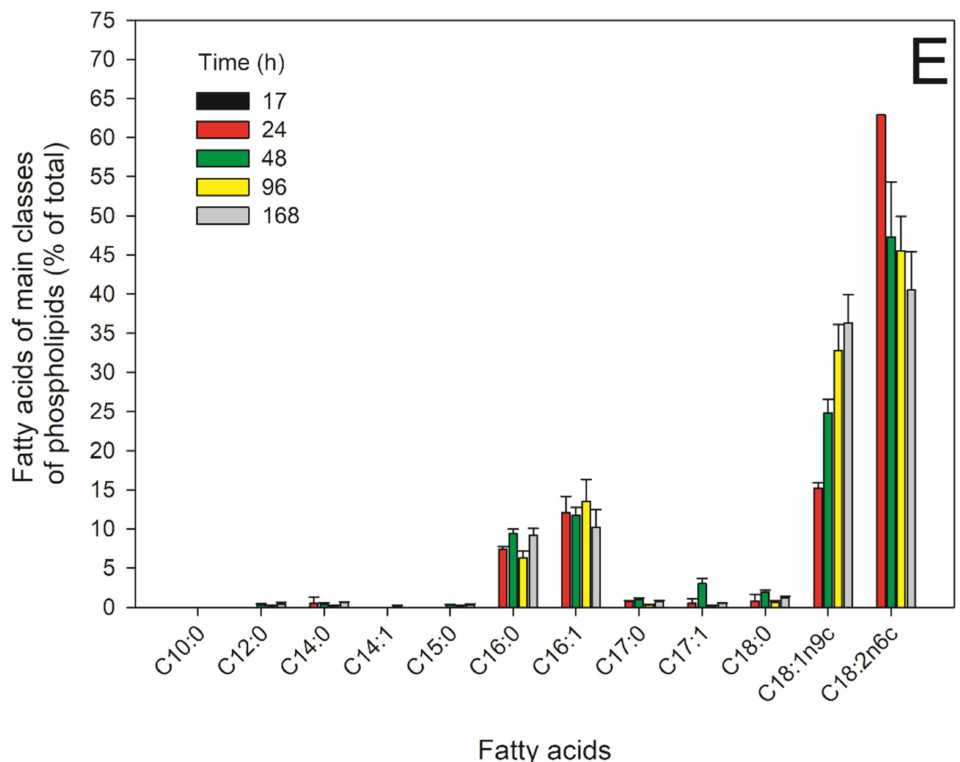
Figure 6. Fatty acid composition of the main membrane PLs in E. magnusii mitochondria in the different growth phases ( A ); PE—phosphatidylethanolamines ( B ); PC—phosphatidylcholines ( C ); CL—cardiolipins ( D ); PA—phosphatidic acids fraction ( E ). Values are mean ± S.E.M from three independent experiments and three analytical